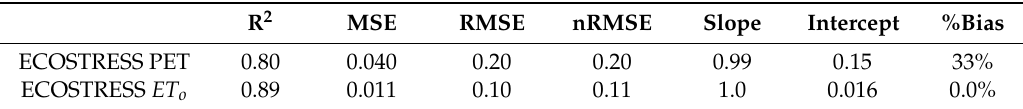
Figure 4. Linear regression was applied to the test data across all five stations ( N = 143), with an overall R 2 of 0.89. Table 1. Summary statistics for simple linear regression for ECOSTRESS PET (pre-calibrated) and ECOSTRESS ET o (calibrated), demonstrating improvements in root mean square error (RMSE), normalized root mean square error (nRMSE), and reduction in percent bias.